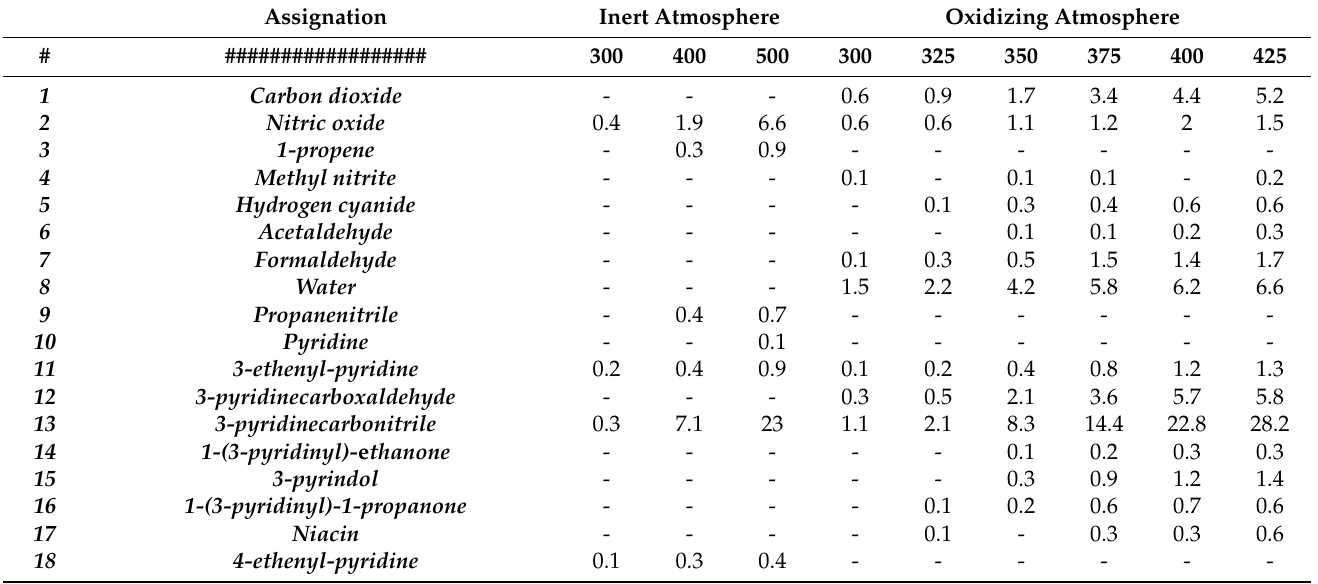
Table A1. Contribution of total area (%) of assigned compounds in the pyrolysis of NNN under inert and oxidizing atmospheres at different temperatures ( ◦